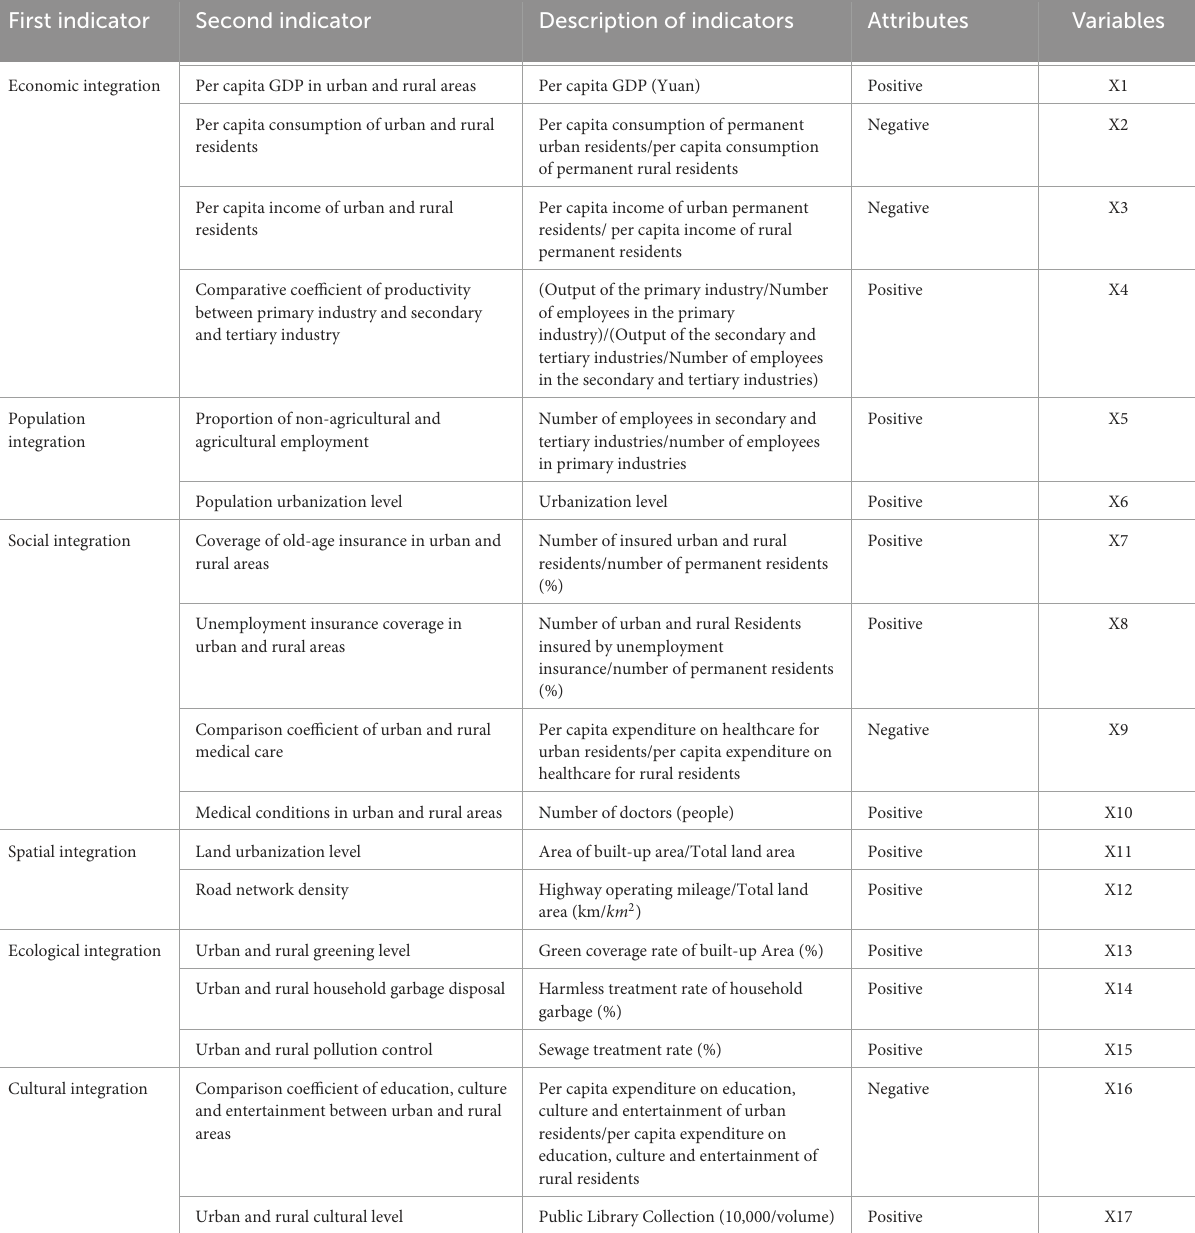
TABLE 1 An evaluation index system of integrated urban-rural development in Yangtze River